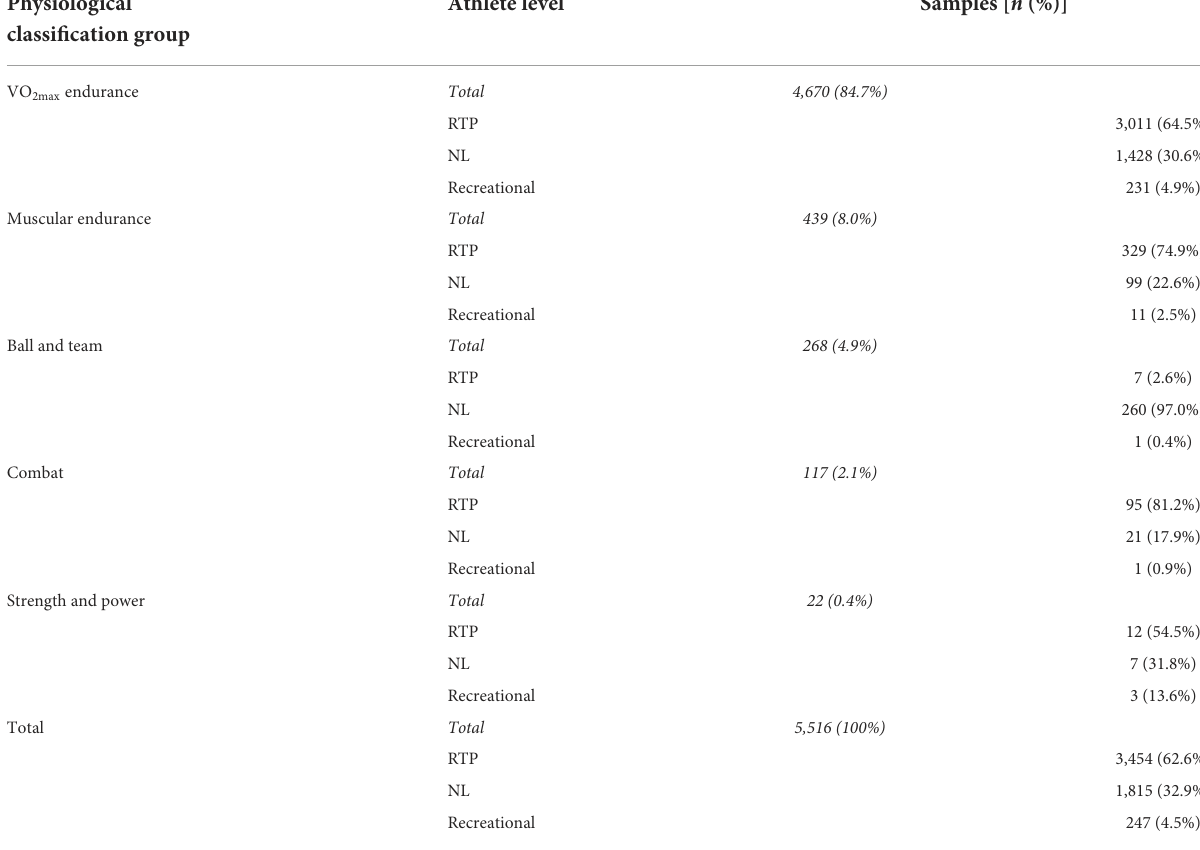
TABLE 2 Number of hematological ABP samples collected in 2010–2019 by physiological classification and athlete level.